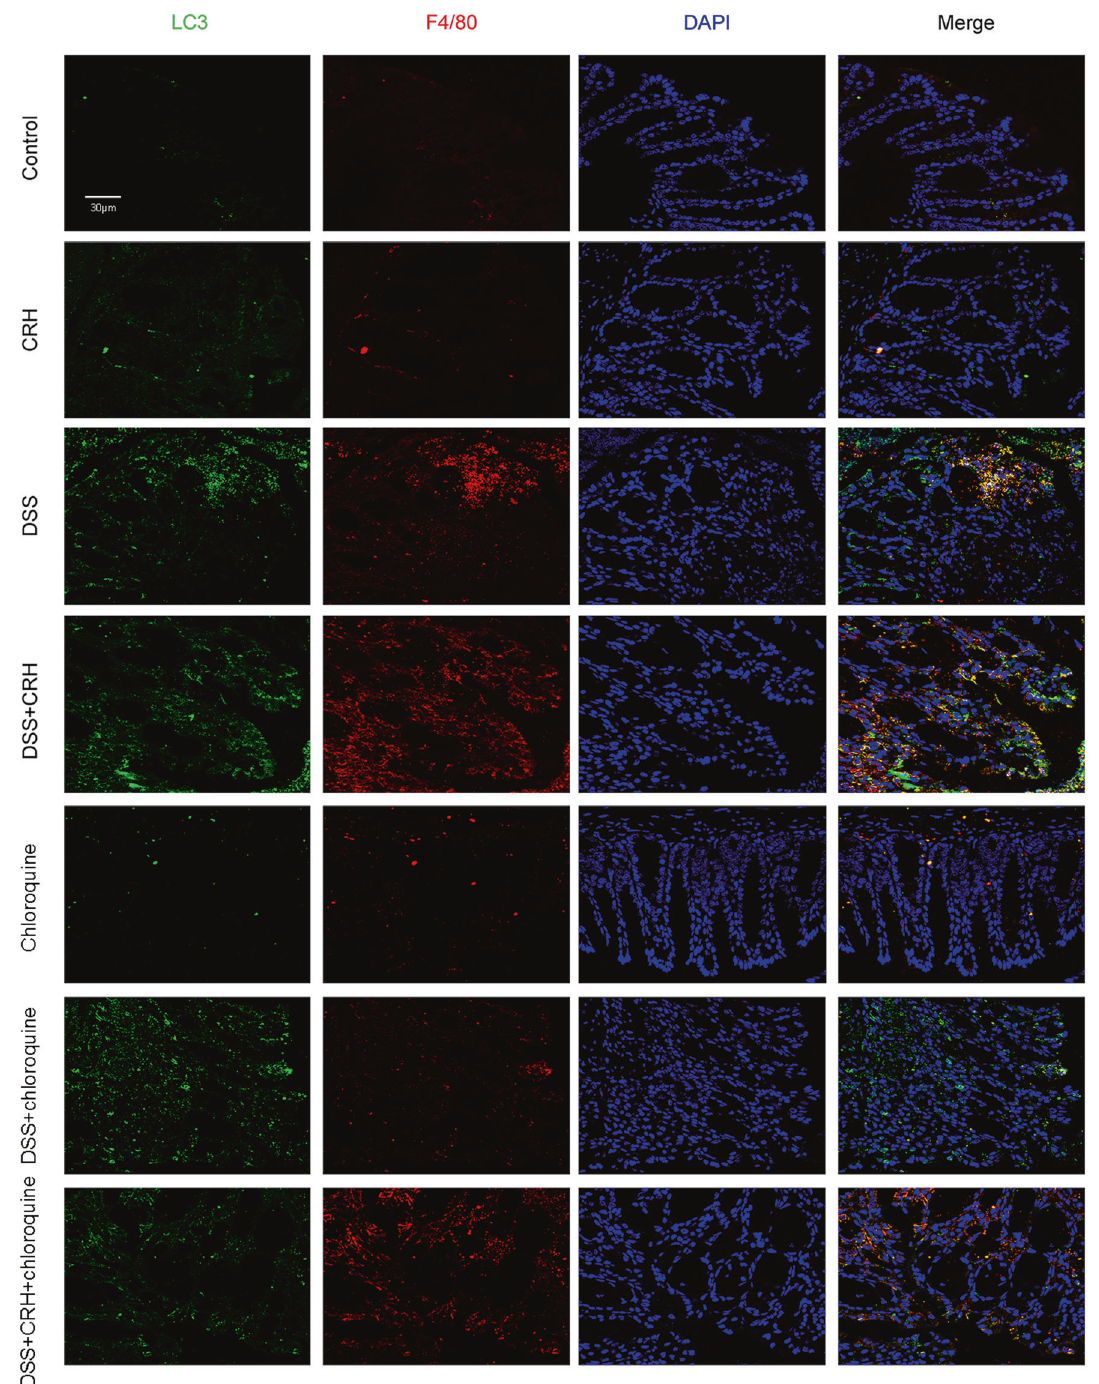
Fig. 6 Chloroquine attenuated the increase in autophagy and number of macrophages in IBD mice. C57BL/6 mice were administered DSS (3%) for 6 days (and a control group was provided with water only for comparison). For the CRH and CRH-rapamycin groups, CRH (50 μ g/kg body weight) and/or rapamycin (1.25 mg/kg body weight) was intraperitoneally injected from day 1 through day 6 using saline as a vehicle. The left edge of the colon was isolated and fi xed, and immuno fl uorescence staining was used to assess the number of macrophages (LC3 dots) and the level of autophagy (F4/80 dots). In comparison with the DSS + vehicle group, mice in the DSS + CRH group demonstrated a signi fi cant increase in the numbers of LC3 dots and F4/80 dots. This increase was attenuated following chloroquine administration. Notably, LC3 dots colocalized obviously with the F4/80